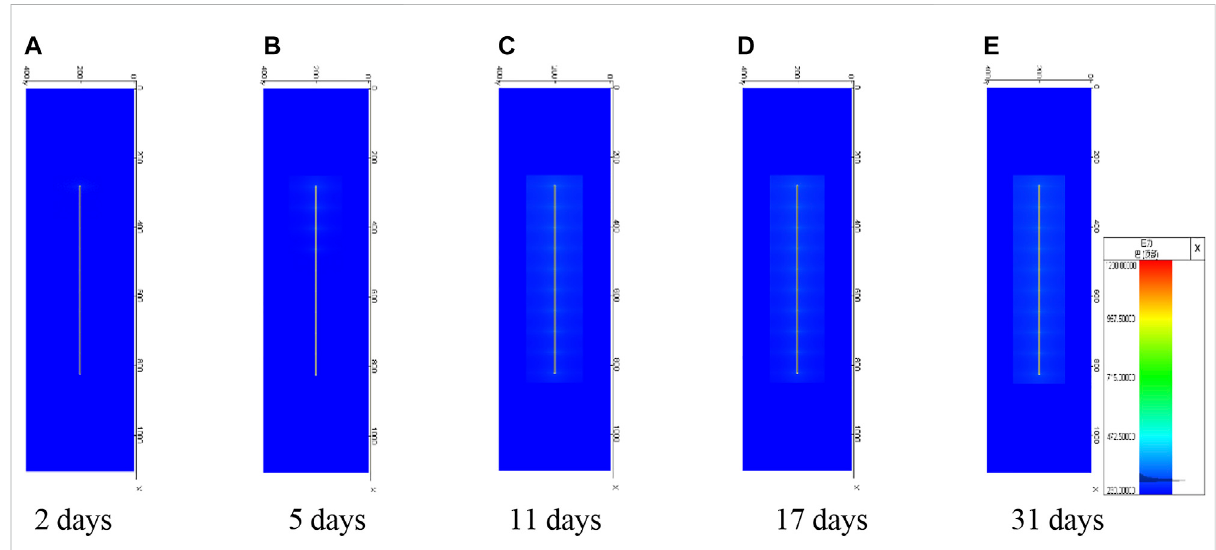
FIGURE 9 Pressure distribution of the shale matrix system during the shut-in period. (A) 2 days, (B) 5 days, (C) 11 days, (D) 17 days, and (E) 31 days.